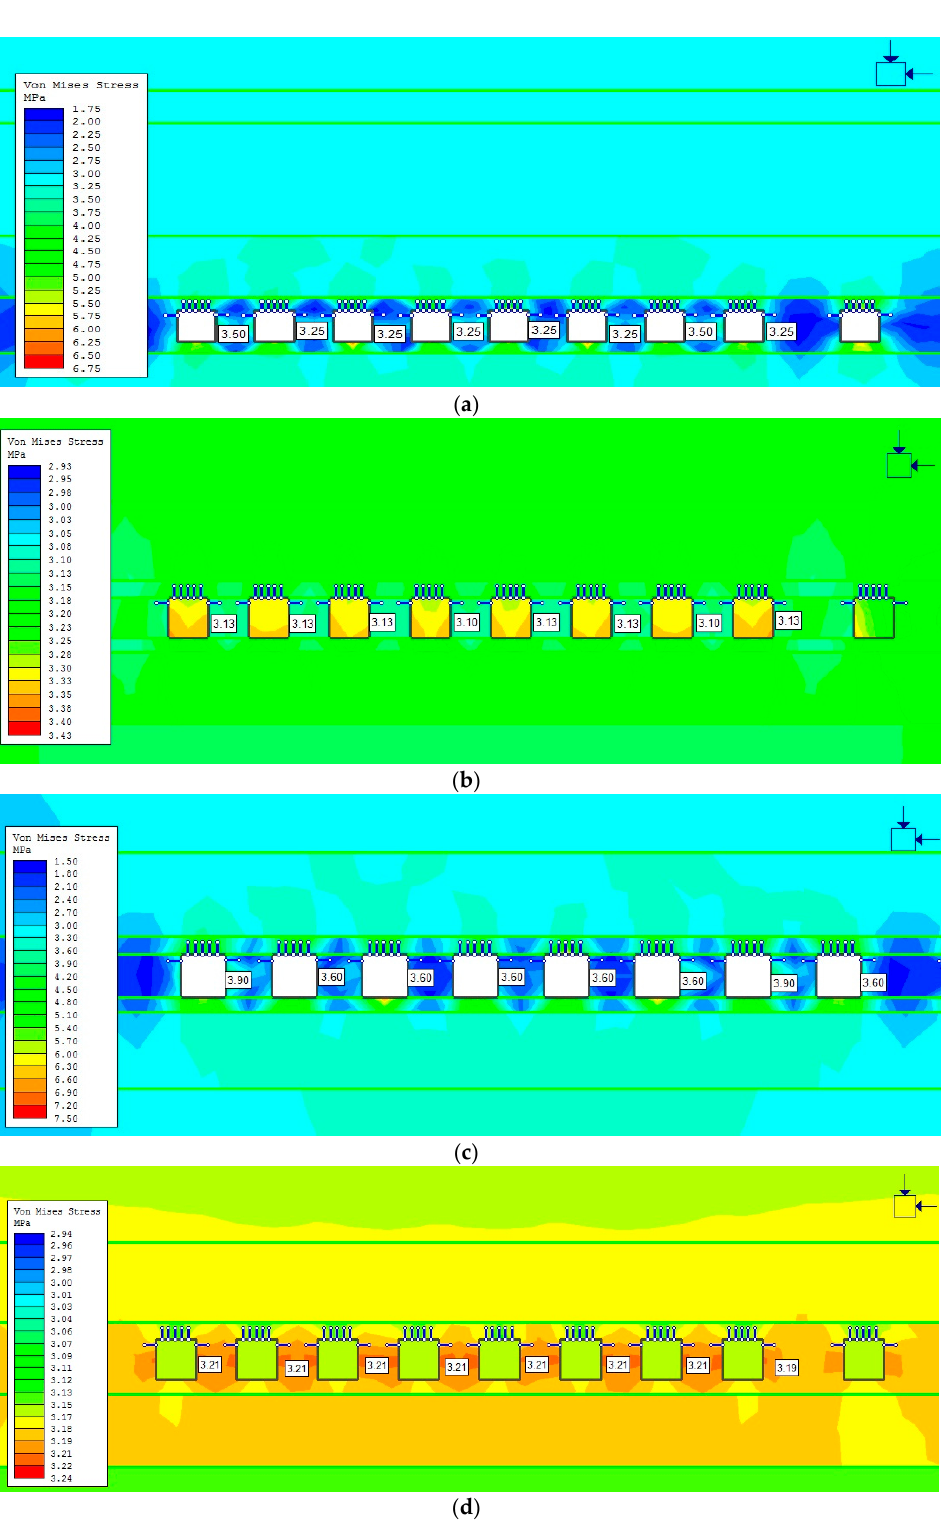
Figure 12. Principal stress for the designed room and pillar method for four cases of exploitation: ( a ) Rock pillars and empty rooms (R1); ( b ) Rock pillars and rooms filled with hydraulic sand filling (R2); ( c ) Rock pillars replaced by wooden cribs filled with waste rocks and empty rooms (R3); ( d ) Rock pillars replaced by wooden cribs filled with waste rocks and rooms filled with hydraulic sand filling